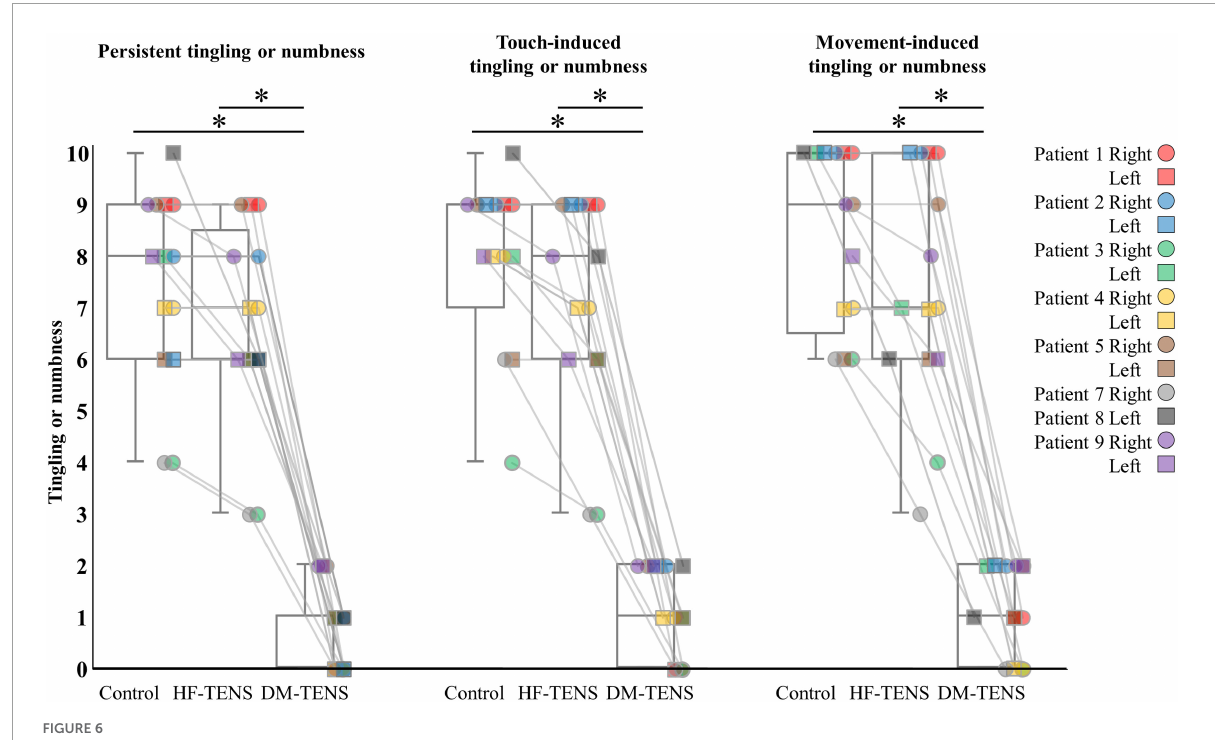
FIGURE6 The specific items of the tingling or numbness symptom for each patient. * p < 0.05.